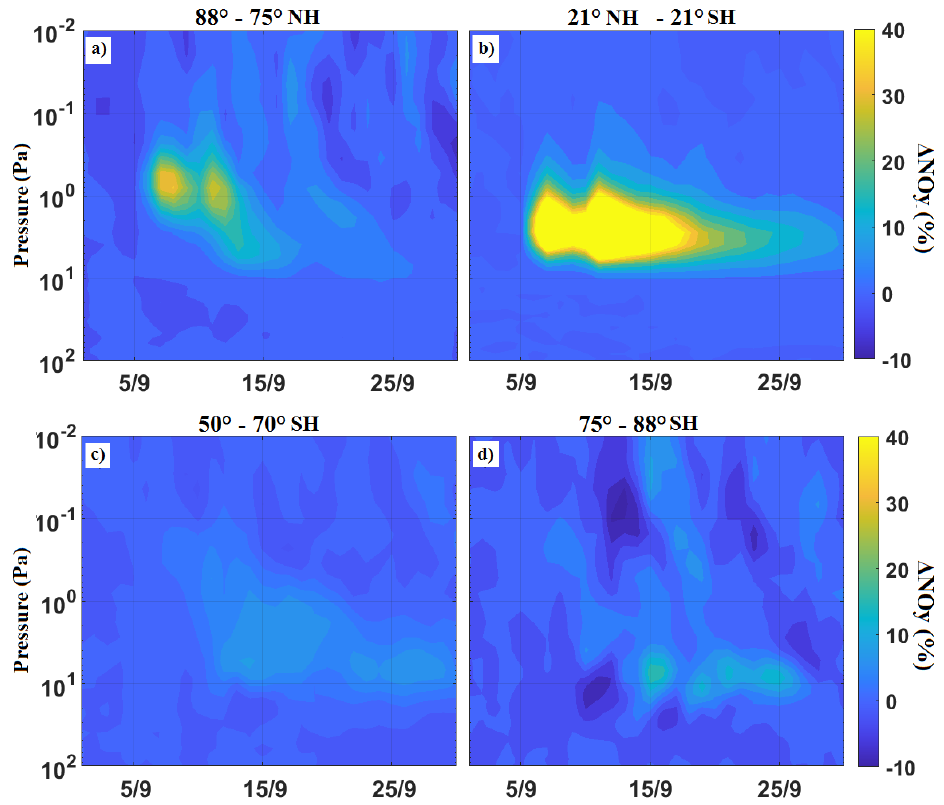
Figure 4. The response of the odd nitrogen family NO y (N, NO, NO 2 , 2N 2 O 5 , HNO 3 ) to solar flares X9.3 on 6 September and X8.2 on 10 September 2017 in the northern polar latitudes ( a ), equatorial latitudes ( b ), southern latitudes ( c ), southern polar latitudes ( d